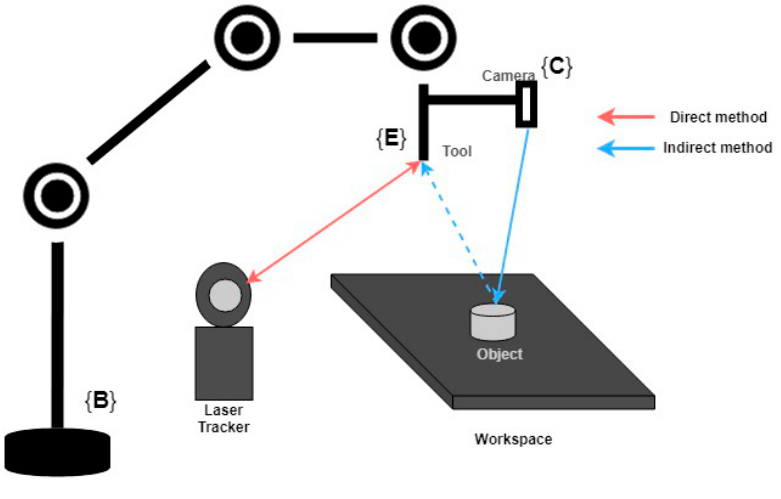
Figure 5. An indirect method for robot calibration.